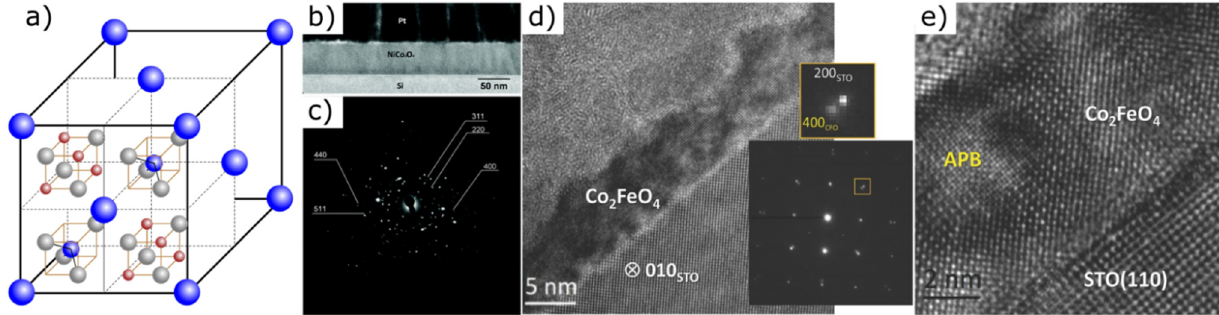
Figure 4. ( a ) Unit cell of spinel AB 2 O 4 (A: blue, B: red, O: grey; orange cubes are also included in the rear half of the unit cell). ( b ) Low-magnification TEM image and ( c ) SAED pattern of a (Co 1-x Ni x ) 3 O 4 film (x = 0.33). Republished from Hagen et al. [184] with permission of Royal Society of Chemistry. Copyright 2021. Permission conveyed through Copyright Clearance Center, Inc. ( d , e ) Cross-sectional TEM images of Co 2 FeO 4 samples grown on (d) SrTiO 3 (001) (inset: corresponding SAED pattern) and ( e ) SrTiO 3 (110), viewed along the zone axis [010] of SrTiO 3 [189].